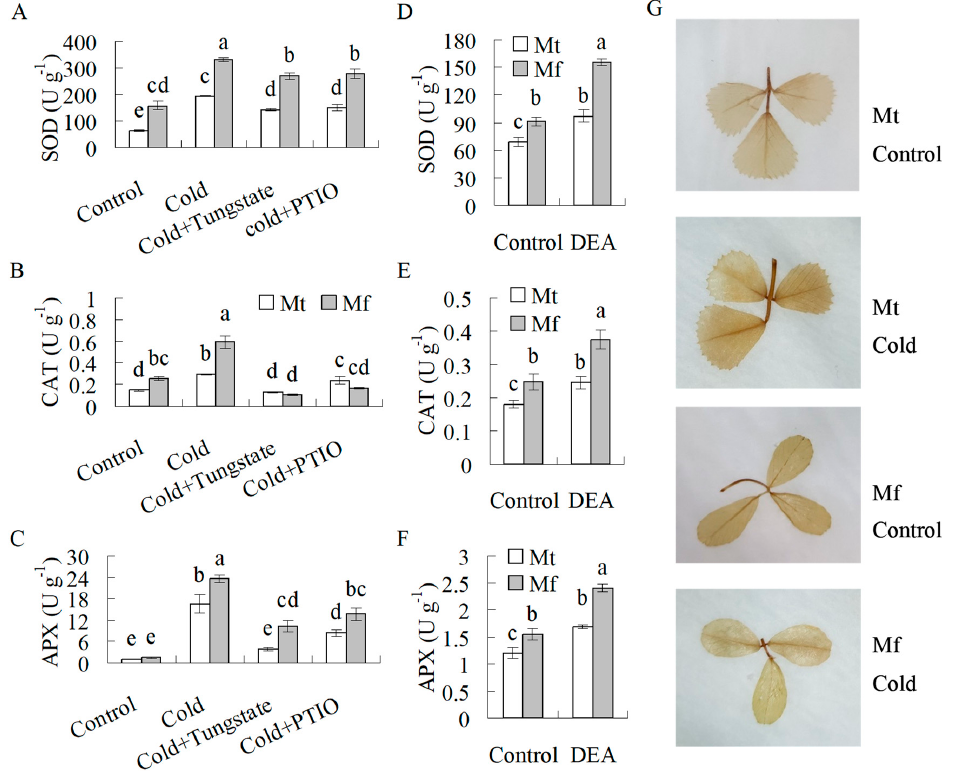
Figure 5. Superoxide dismutase (SOD, A , D ), catalase (CAT, B , E ), and ascorbate ‐ peroxidase (APX, C , F ) activities as well as H 2 O 2 accumulation ( G ) in response to cold treatment or DEA treatment in M. falcat a (Mf) in comparison to M. truncatula (Mt). Ten ‐ week ‐ old M. falcata and M. truncatula cv. A17 plants were irrigated with 15 mL of 1 mM tungstate or 100 μ M 2 ‐ phenyl ‐ 4,4,5,5 ‐ tetramethylimidazoline ‐ 1 ‐ oxyl 3 ‐ oxide (PTIO) solution or H 2 O as a control, followed by exposure